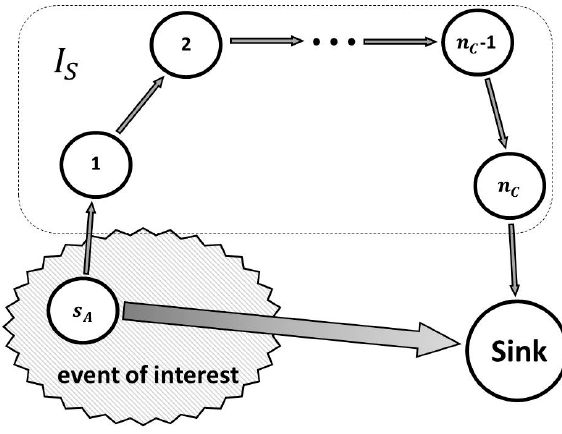
Figure 4. DoB attack based on excessive transmission power.